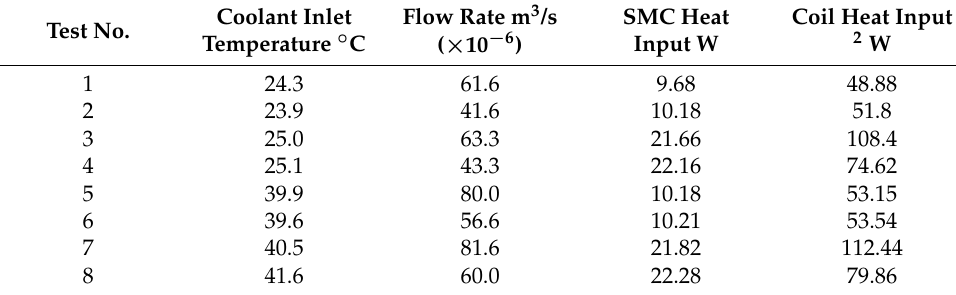
Table 7. Transient calibration of the new construction. Test